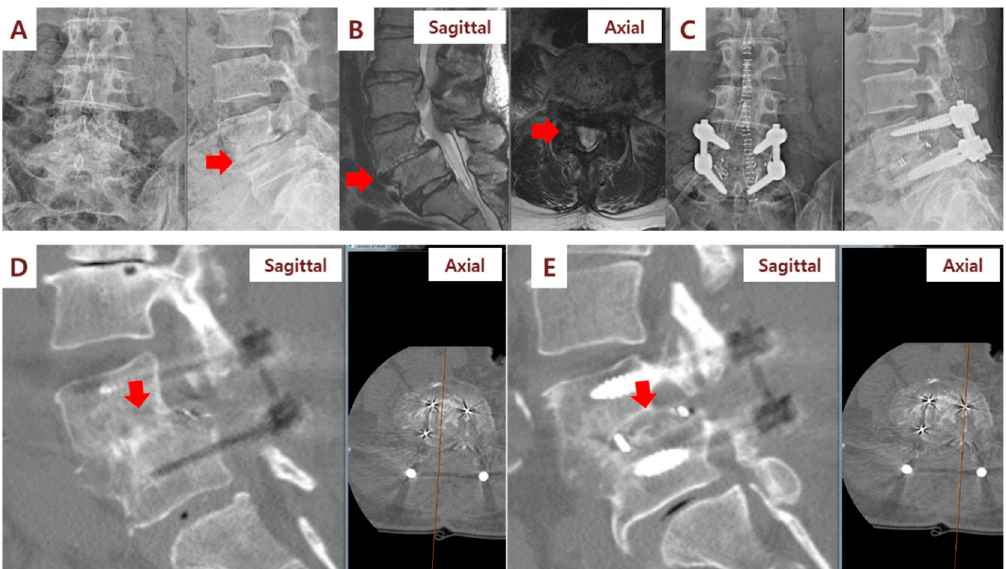
Table 2. Assessment of fusion grade by Brantigan–Steffee